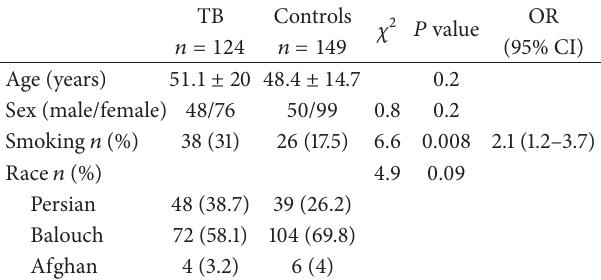
Table 2: Demographic characteristics of TB patients and